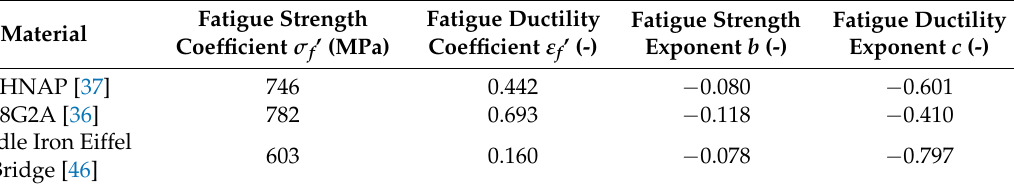
Table 3. Low cycle fatigue properties of the analyzed materials.